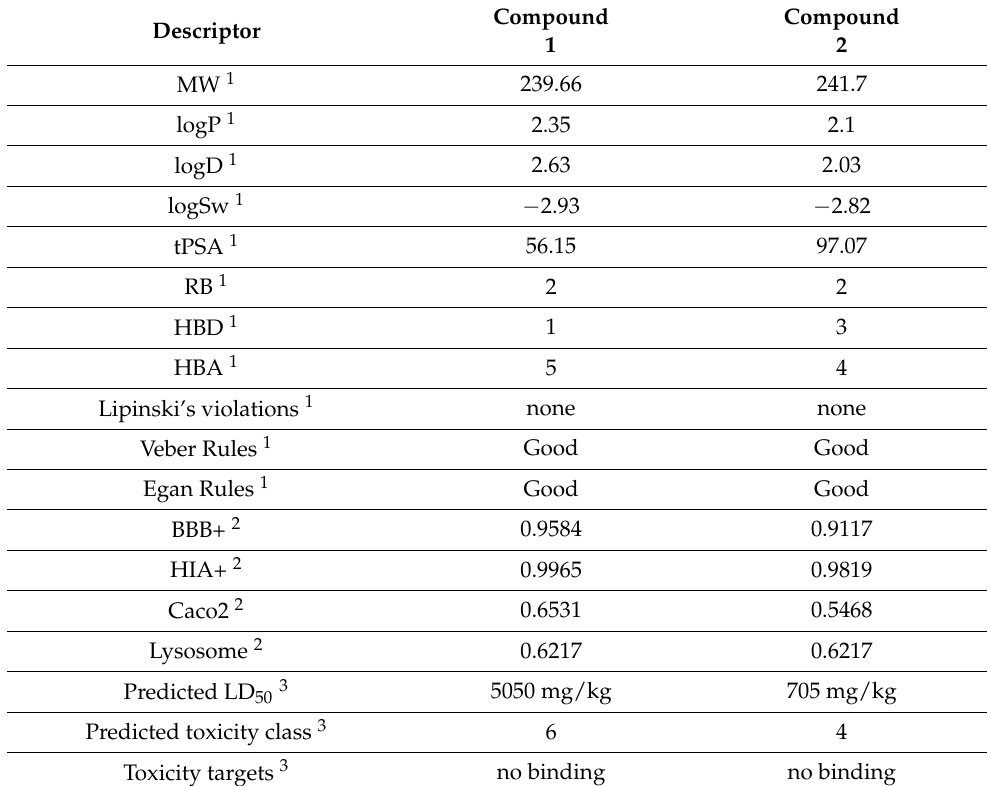
Table 3. In-silico predicted physicochemical parameters and ADME-Tox profiling of compounds 1 and 2